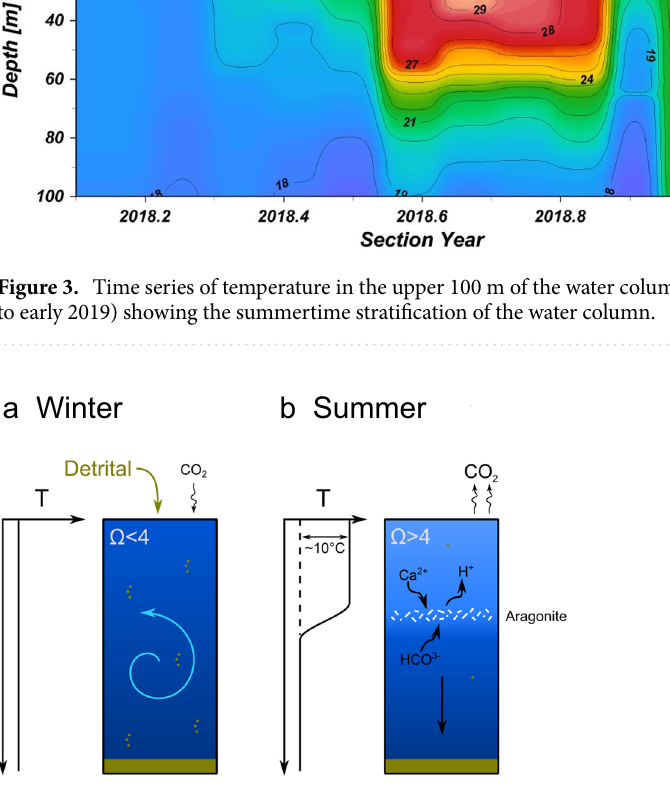
Figure 4. Schematic model for aragonite formation in the Eastern Mediterranean. During cooling events and vertical mixing of the water column ( a ), the cooler water with increased productivity acts as a CO 2 sink. During prolonged periods of warming ( b ), the water column becomes thermally stratified, CO 2 degasses due to super saturation, CO 3 −2 and Ω Ar increase, and abiotic aragonite precipitation occurs and intensify CO 2 supersaturation and